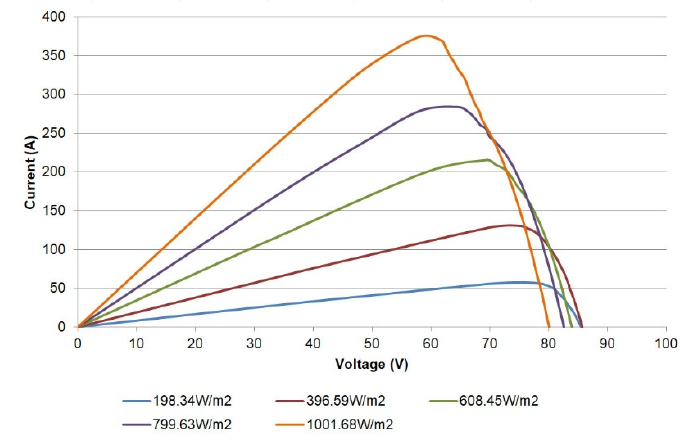
Figure 18. I ‐ V curves for two PV modules connected in series.